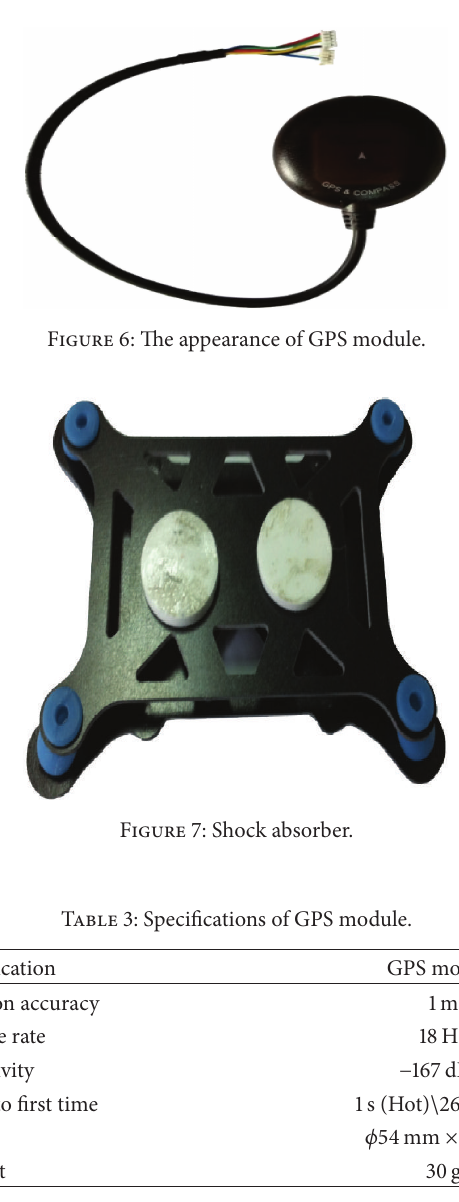
Figure 5: Flight control system in our helicopter.